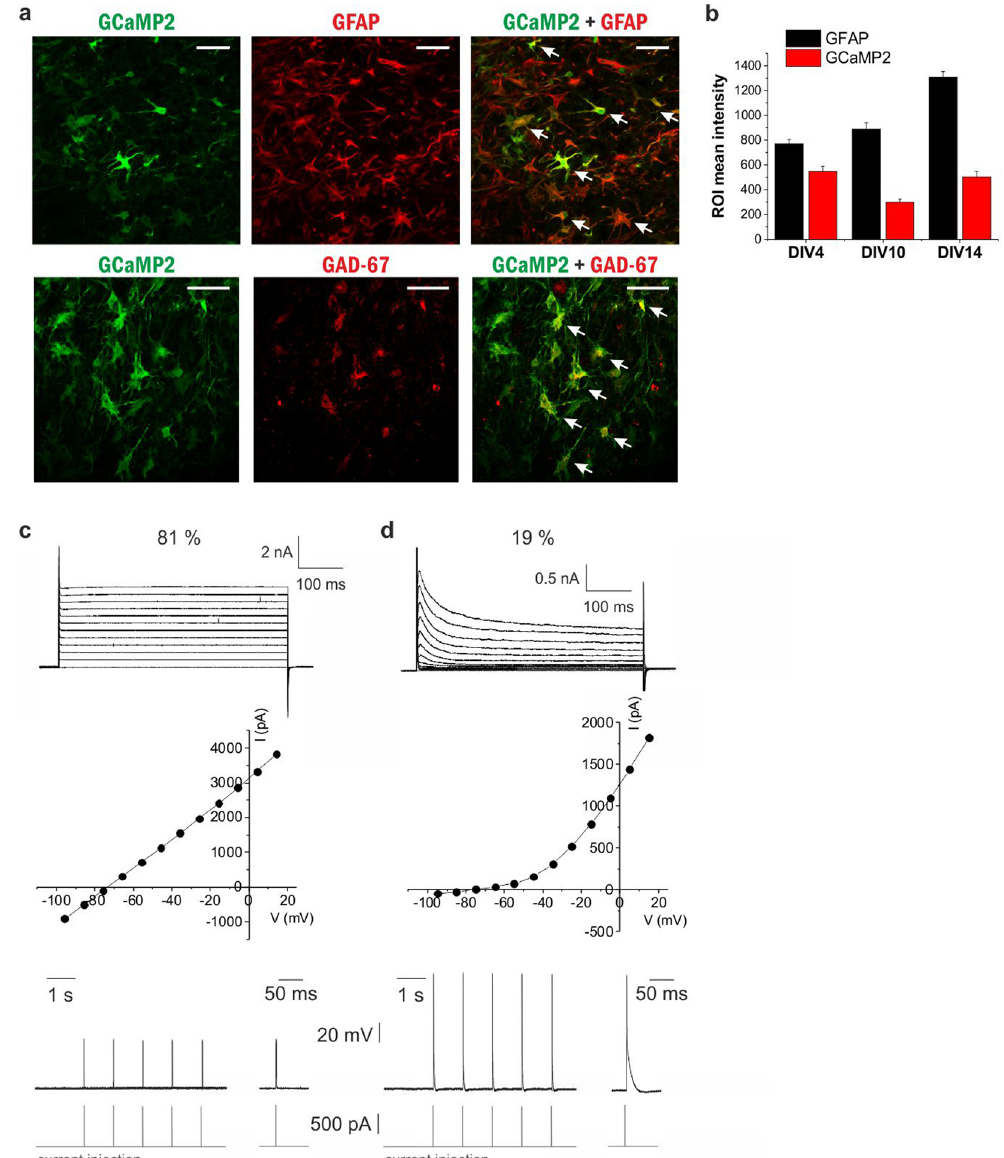
Figure 1. GCaMP2 is expressed in astrocytes and interneurons ( A ) Astrocytic and neuronal localization of GCaMP2 protein in organotypic cortical slices as shown by colocalization with the astrocyte-specific GFAP and interneuron-specific GAD-67 markers. Cells showing colocalization are marked by arrows. Scale bars: 50 μ m. ( B ) Changes in GCaMP2 and GFAP expression as measured by average intensity within cell ROIs (n = 22–34 cells) in organotypic cortical slices as a function of days in culture (DIV). ( C , D ) Representative traces (top), I/V plot (middle) and action potential generating ability (bottom) of whole-cell patched GCaMP2 expressing astrocytes ( C , n = 30) and neurons ( D , n = 7) in organotypic cortical